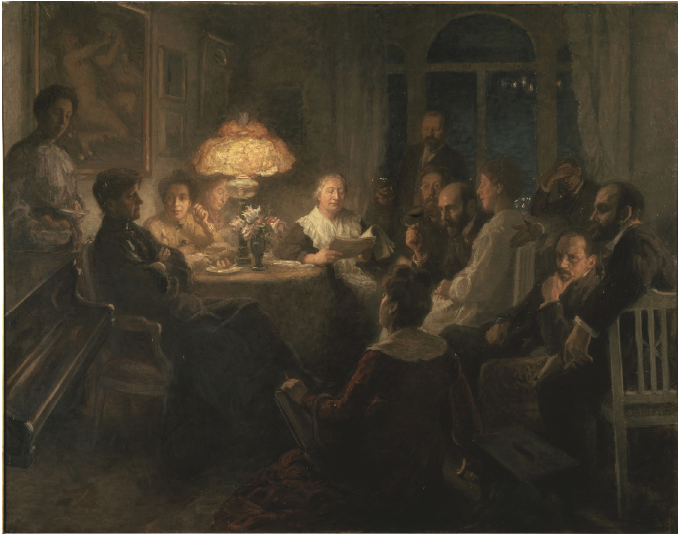
Figure 1. Hanna Pauli (1864–1940): Vännerna (“The Friends”), 1900–1907, oil on canvas, 204 cm × 260 Figure cm, Nationalmuseum Stockholm, Public domain.